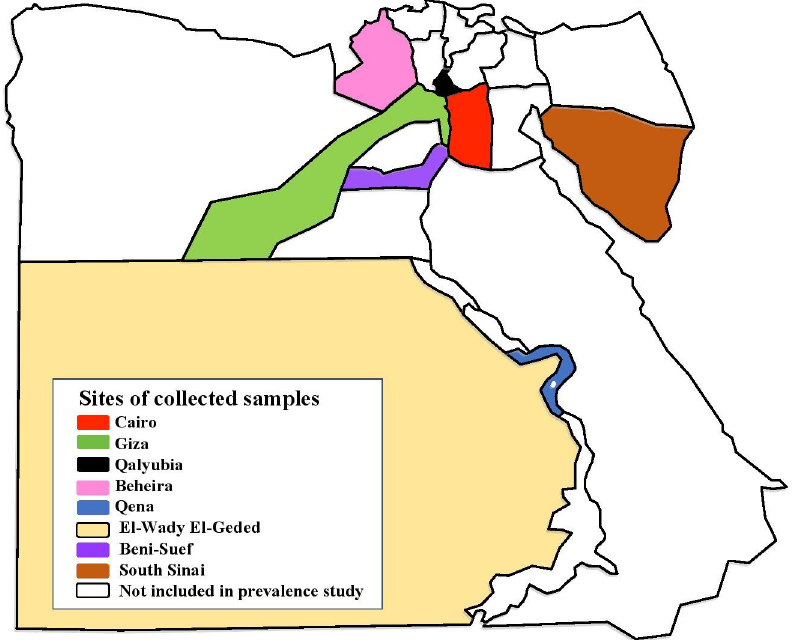
Fig 1. Map of Egypt showing the different provinces where the blood samples from different animal hosts were collected for our study. https://en.wikipedia.org/wiki/Governorates_of_Egypt and the picture has CC BY-SA 3.0.